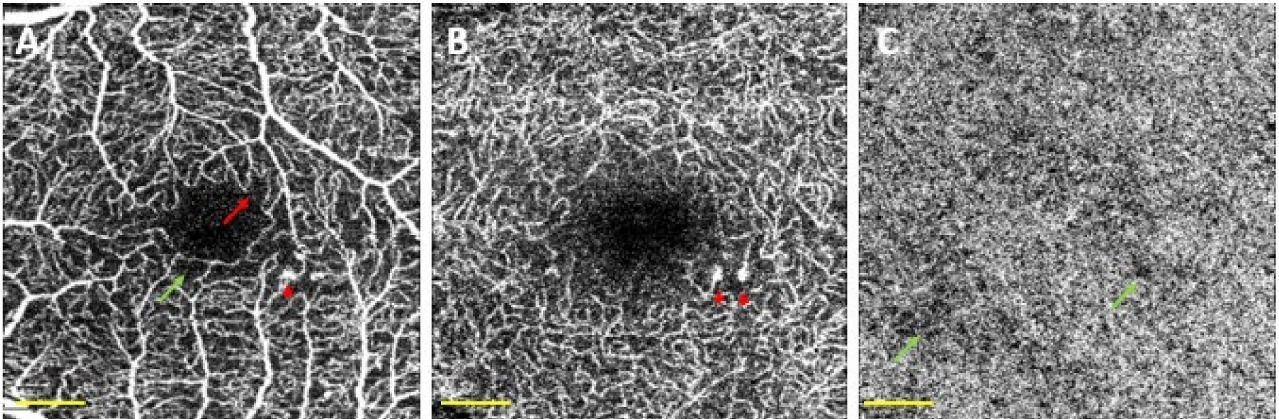
Figure 4. Optical coherence tomography angiography (OCTA) of a diabetic patient without de- tectable diabetic lesions. OCTA was acquired using DRI-Triton SS-OCT (Topcon, Tokyo, Japan) with a 3 × 3 mm scan protocol. ( A ) Superficial capillary plexus, ( B ) deep capillary plexus, and ( C ) chorio- capillaris (CC). Red arrow shows a disruption in the foveal avascular zone (FAZ), red arrowheads correspond to microaneurysms, and green arrows correspond to non-perfusion areas in the CC. Scale bar (in yellow) represents 500